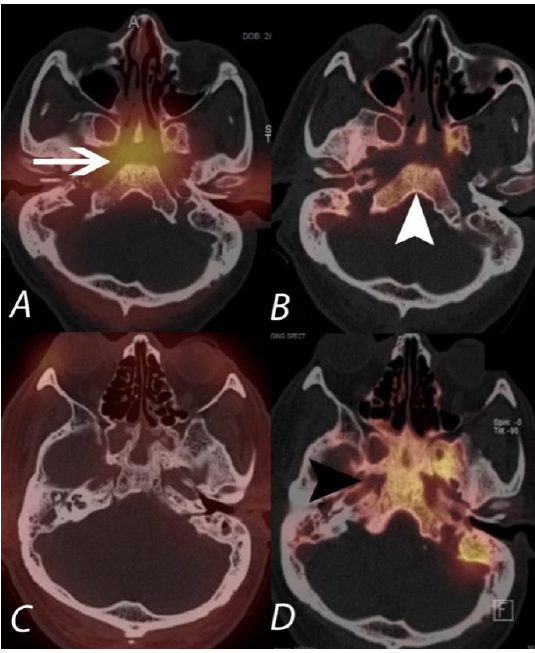
Figure 15. The upper panel ( A , B ) demonstrates 67 Ga and 99m Tc MDP SPECT/CT scans in a patient being evaluated for acute malignant otitis externa. While 99m Tc MPD SPECT/CT shows uptake in the bones of the central skull base (white arrowhead), consistent with osteomyelitis, the 67 Ga also demonstrates soft tissue infection at the central skull base and around the external auditory canals. The lower panel ( C , D ) is of a different patient with continued pain following completion of an antibiotic regimen for skull base osteomyelitis. The 99m Tc MDP SPECT/CT (right lower panel) shows post-infectious remodeling hyperostosis of the bones of the central skull base, but the 67 Ga SPECT/CT (left lower panel) shows an absence of active